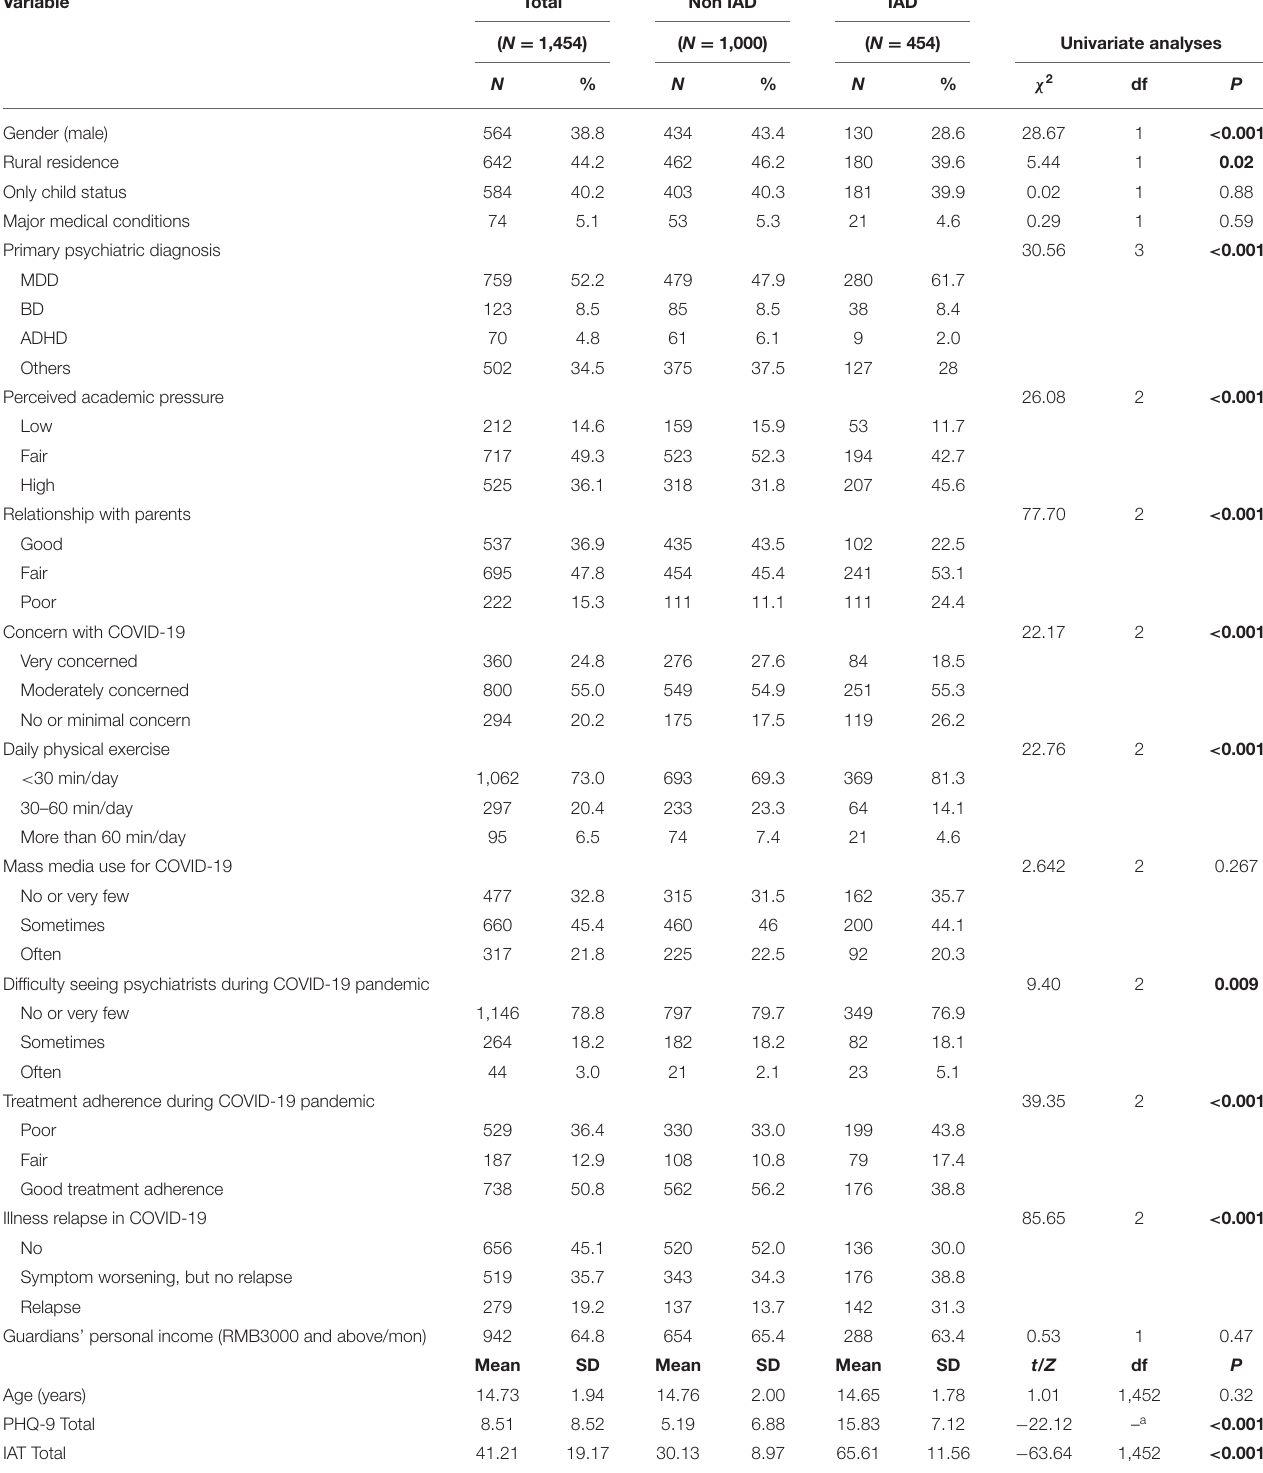
TABLE 1 | Socio-demographic and clinical characteristics of adolescent patients.